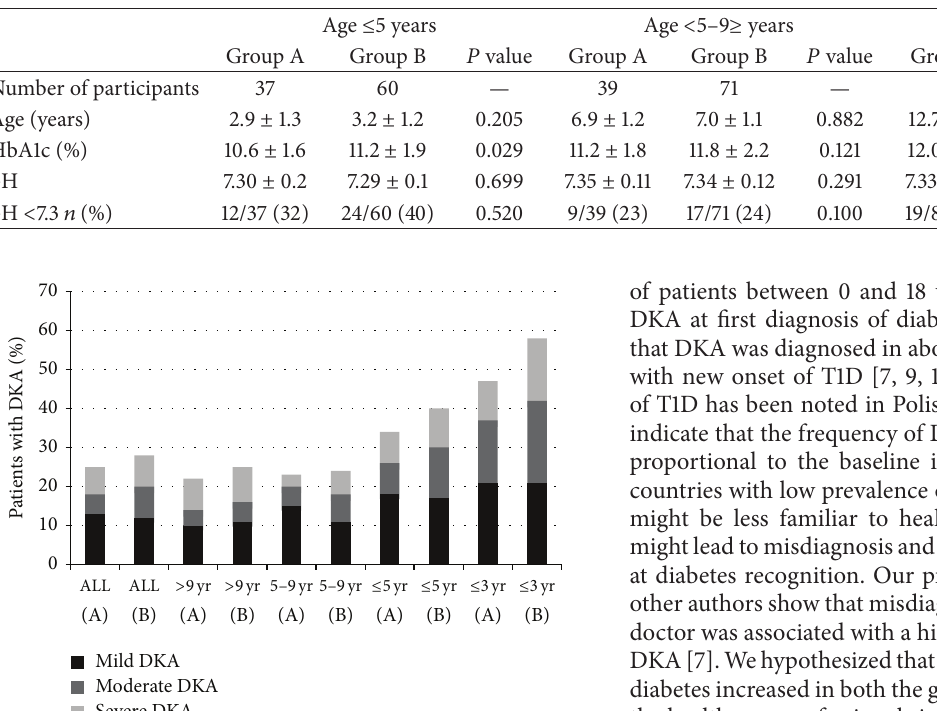
Table 2: Comparisons between groups in regard to age.